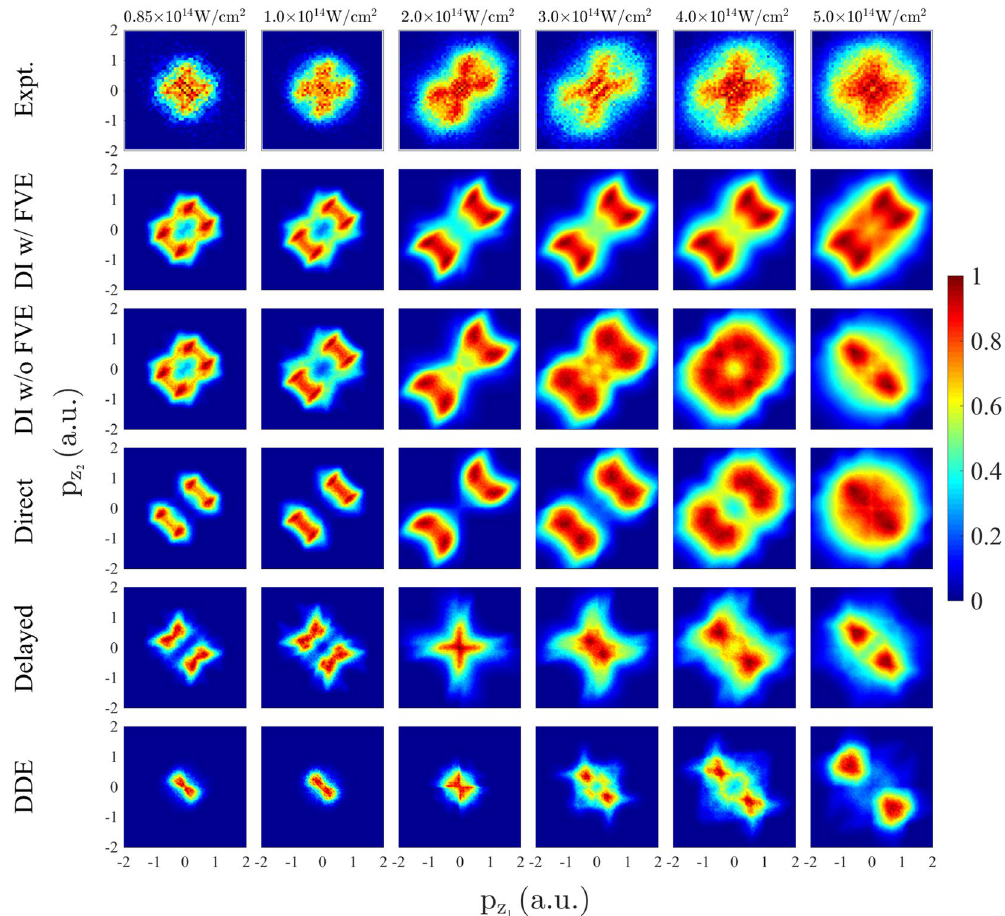
Figure 5. First row: measured correlated electron momenta 8 . Second row: computed correlated electron momenta for all double ionization events with the focal volume effect accounted for. Third row: computed correlated electron momenta for all double ionization events with the focal volume effect not accounted for. Fourth row: correlated electron momenta for the direct pathway of double ionization with the focal volume effect not accounted for. Fifth row: correlated electron momenta for the delayed pathway of double ionization with the focal volume effect not accounted for. Sixth row: correlated electron momenta for the double delayed pathway of double ionization with the focal volume effect not accounted for. The sum of the fourth row plus the fifth row plus the sixth row is equal to the third row. Each double differential distribution is divided by its maximum